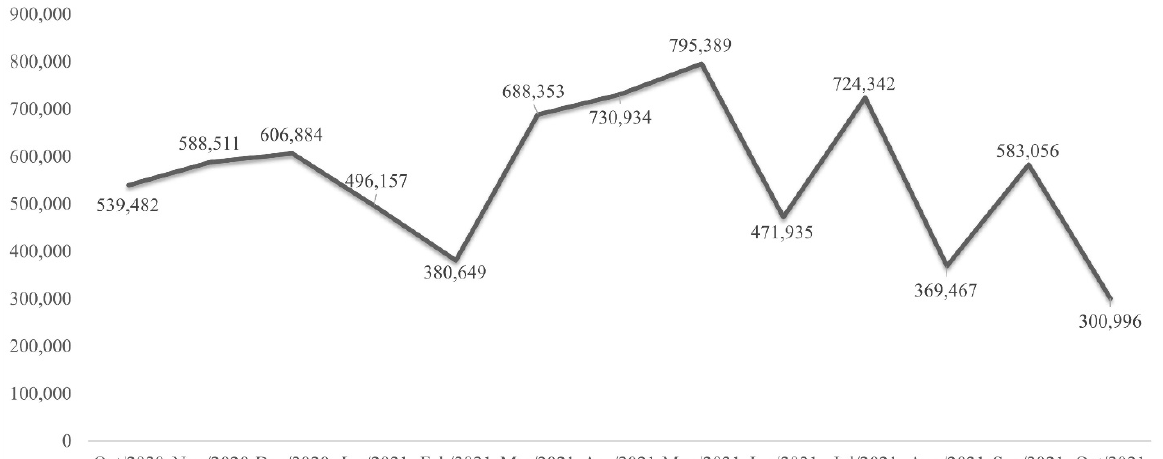
Figure 1. Tourism arrivals to Macao from mainland China.